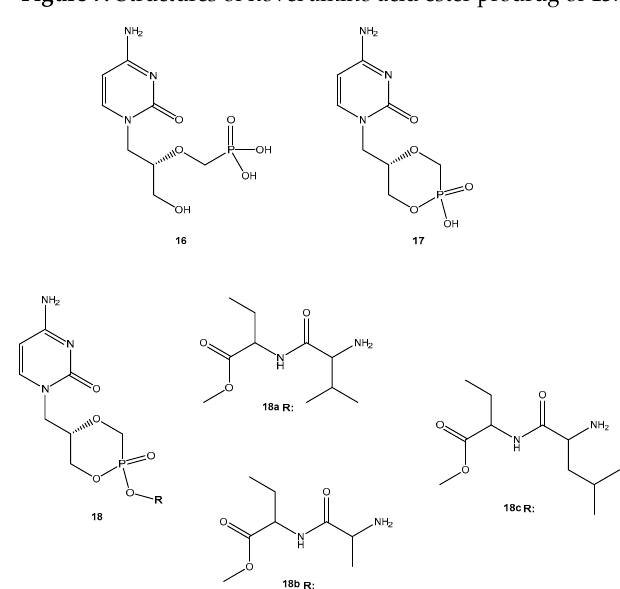
Figure 7. Structures of novel amino acid ester prodrug of 13 . Molecules 2018 , 23 , x FOR PEER REVIEW